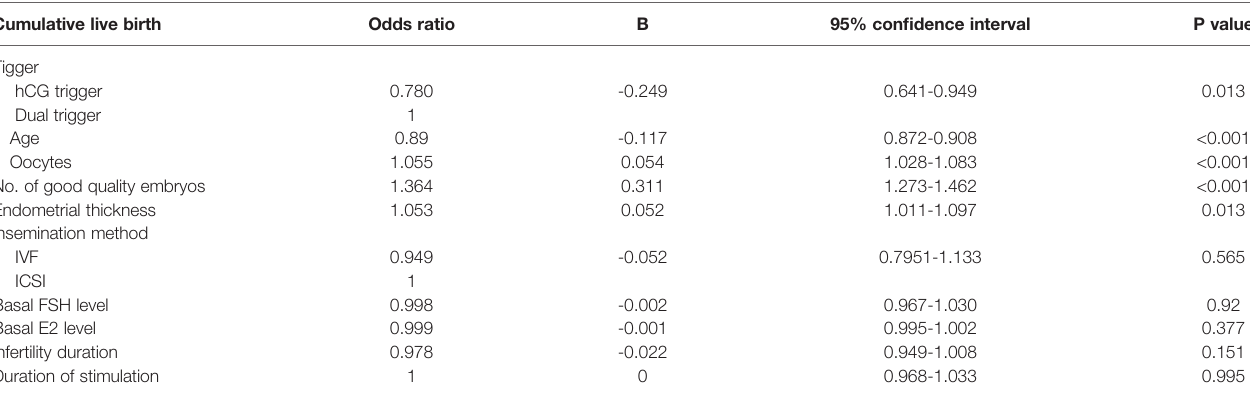
TABLE 4 | Logistic regression analysis with odds ratios for the CLBR. Cumulative live